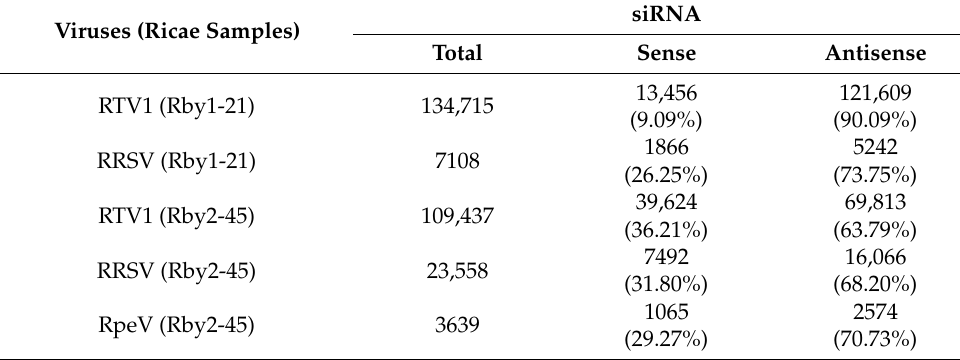
Table 2. Abundance and distribution of small interfering RNA in rice